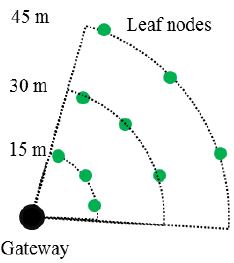
Figure 7. Small-scale test topology.